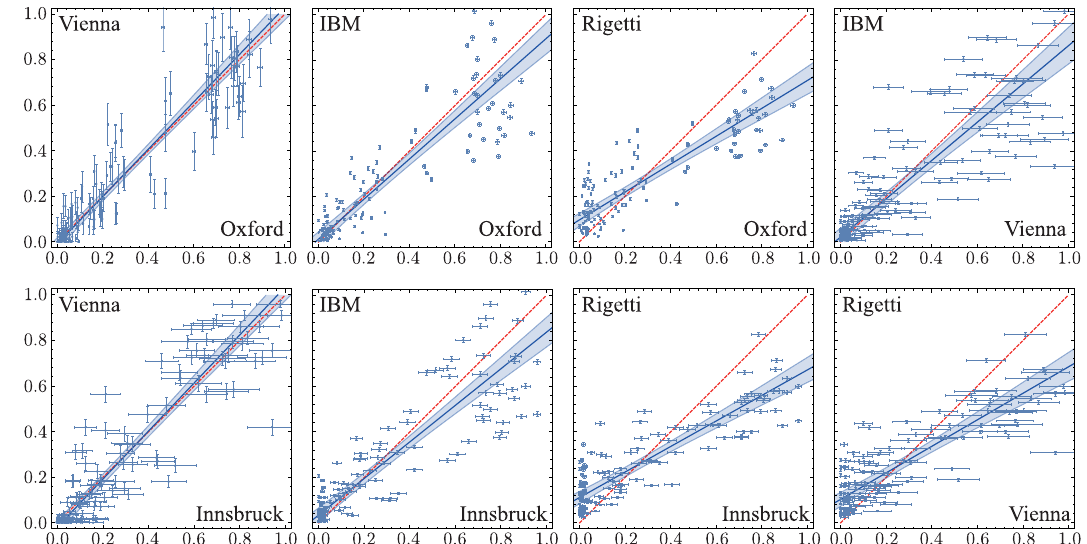
FIG. 4. Experimental comparison between outputs of computations for pairs of different devices. Data points represent the (rescaled) outcome probabilities of one device (horizontal axis, bottom label) versus another (vertical axis, top label), for MBQC-related instances. We compare all pairs of independent devices, implementing different-size circuits and based on different physical systems. In the ideal case, all points should, up to unavoidable shot noise, lie on the diagonal. For each data set containing 136 outcome probabilities (34 circuits and four outcome combinations each), we perform linear total least-squares regression (solid blue line) to quantify the deviation from the ideal correlation (red dashed line), yielding regression slopes with 1 σ uncertainties of (top, left to right) 1.04(2), 0.88(3), 0.61(2), 0.84(3), (bottom, left to right) 1.05(2), 0.80(3), 0.56(2), and 0.58(2), respectively. Experimental error bars correspond to 1 σ statistical uncertainty associated with the data points, and the blue shaded bands represent 3 σ mean prediction intervals for the